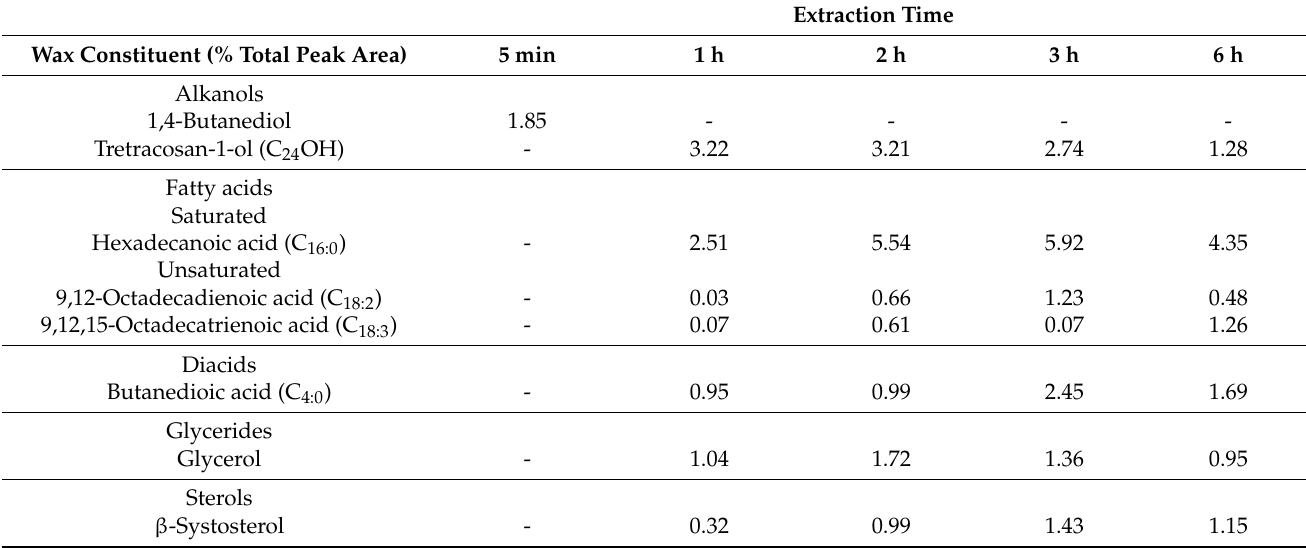
Table 5. Composition of the cuticular waxes of cork oak leaves solubilised in acetone with different extraction times, as determined by GC–MS, in % of total peak area (only compounds with over 1% are shown; complete composition in Supplementary Table